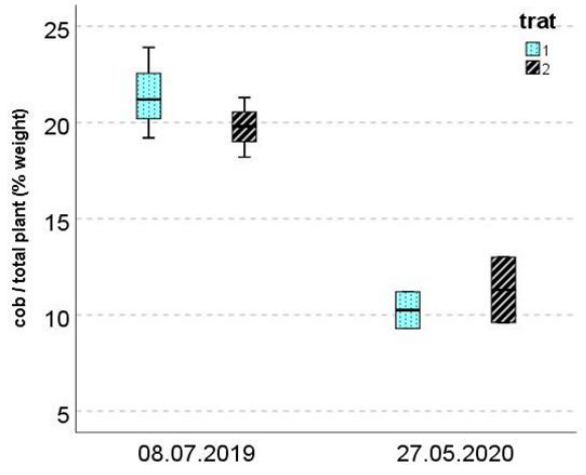
Figure 4. Ratio of cob/total plant weight (in %), calculated in both 2019 and 2020.